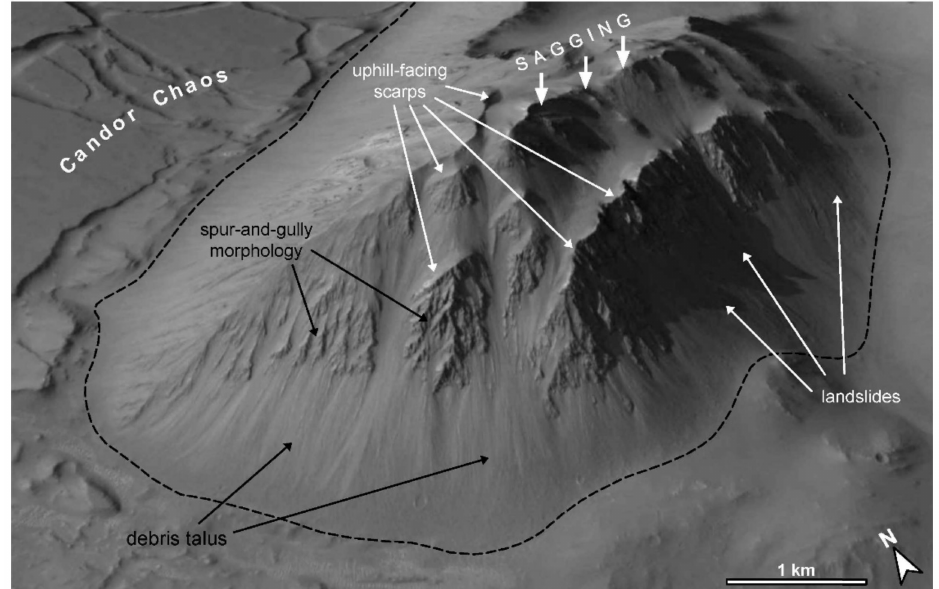
Figure 7. Example of DSGSD along the western margin of the inner ridge of Candor Chaos, north of Melas Labes. The double-sided gravity-induced deformation is characterized by a crestal sagging, related to uphill-facing scarps located on the ridge margin. In the southern sector, three landslides that involve the debris deposits are present. The bedrock outcrop is characterized by spur-and-gully morphology from which the debris talus deposits originate. This Mars image was produced with Google Mars, based on the MOLA gridded elevation data and CTX